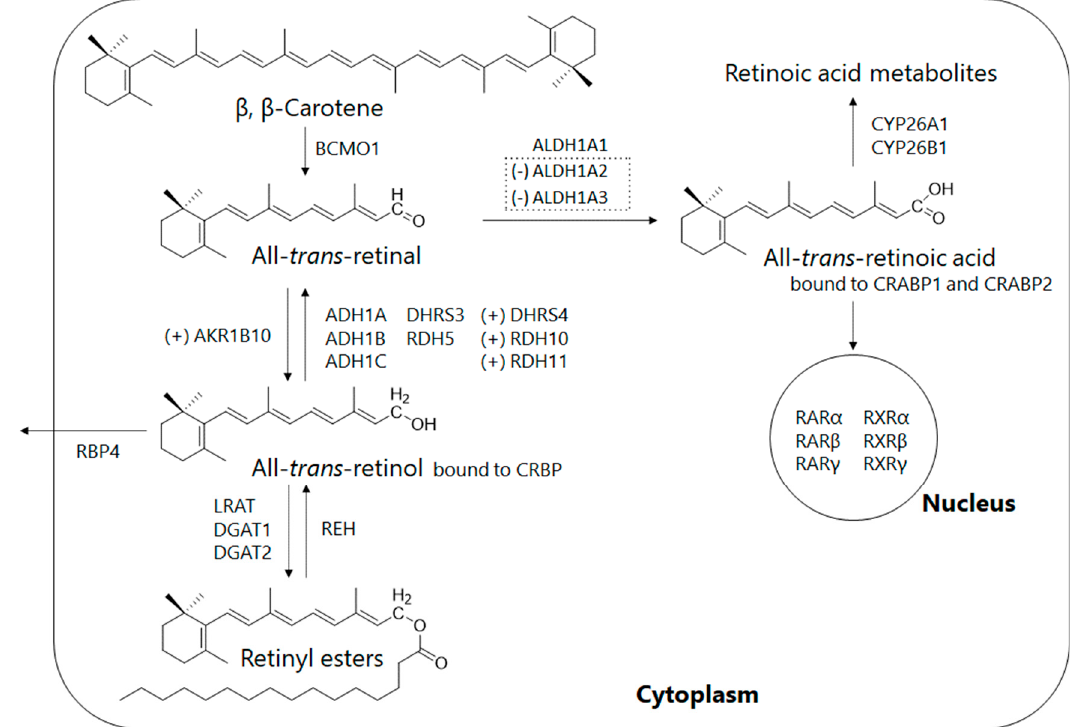
Figure 3. Intracellular metabolic pathway of retinoid in the liver: The all-trans-retinol binds to cellular retinol-binding protein (CRBP) and is esterized by lecithin retinol acyltransferase (LRAT) and diacylglycerol acyltransferases (DGAT1, DGAT2) for intracellular storage, whereas retinol bound with retinol-binding protein 4 (RBP4) is transported into other tissues via blood circulation. Retinol is oxidized into all-trans-retinoic acid in the liver via two stages as follows: The reversible oxidation/reduction between retinol and retinal is regulated by three kinds of enzymes: (i) retinal dehydrogenases (RDH5, RDH10, RDH11), (ii) alcohol dehydrogenases (ADH1A, ADH1B, ADH1C); and (iii) membrane-bound short-chain dehydrogenases (DHRS3, DHRS4). The irreversible oxidation of retinal to all-trans-retinoic acid is maintained by retinaldehyde dehydrogenases 1 (ALDH1A1, ALDH1A2 and ALDH1A3). All-trans-retinoic acid, which binds to cellular retinoic acid-binding proteins (CRABP1 and CRABP2), is eliminated from the body by the cytochrome P450 (CYP26A1 and CYP26B1)-dependent oxidation. After entering the nucleus, all-trans-retinoic acid binds to a retinoic acid receptor/retinoic X receptor (RAR/RXR) heterodimer and stimulates transcription of target genes. In NAFL and NASH, the (+) symbol means an increased expression of aldo-keto reductase 1 B10 (AKR1B10), whereas the ( − ) symbol means a reduced expression of retinaldehyde dehydrogenase 1. Provitamin A is metabolized to all-trans-retinal by β -carotene 15,15 ′ -monooxygenase 1 (BCMO-1) in vitamin A deficient states such as NAFL and NASH.